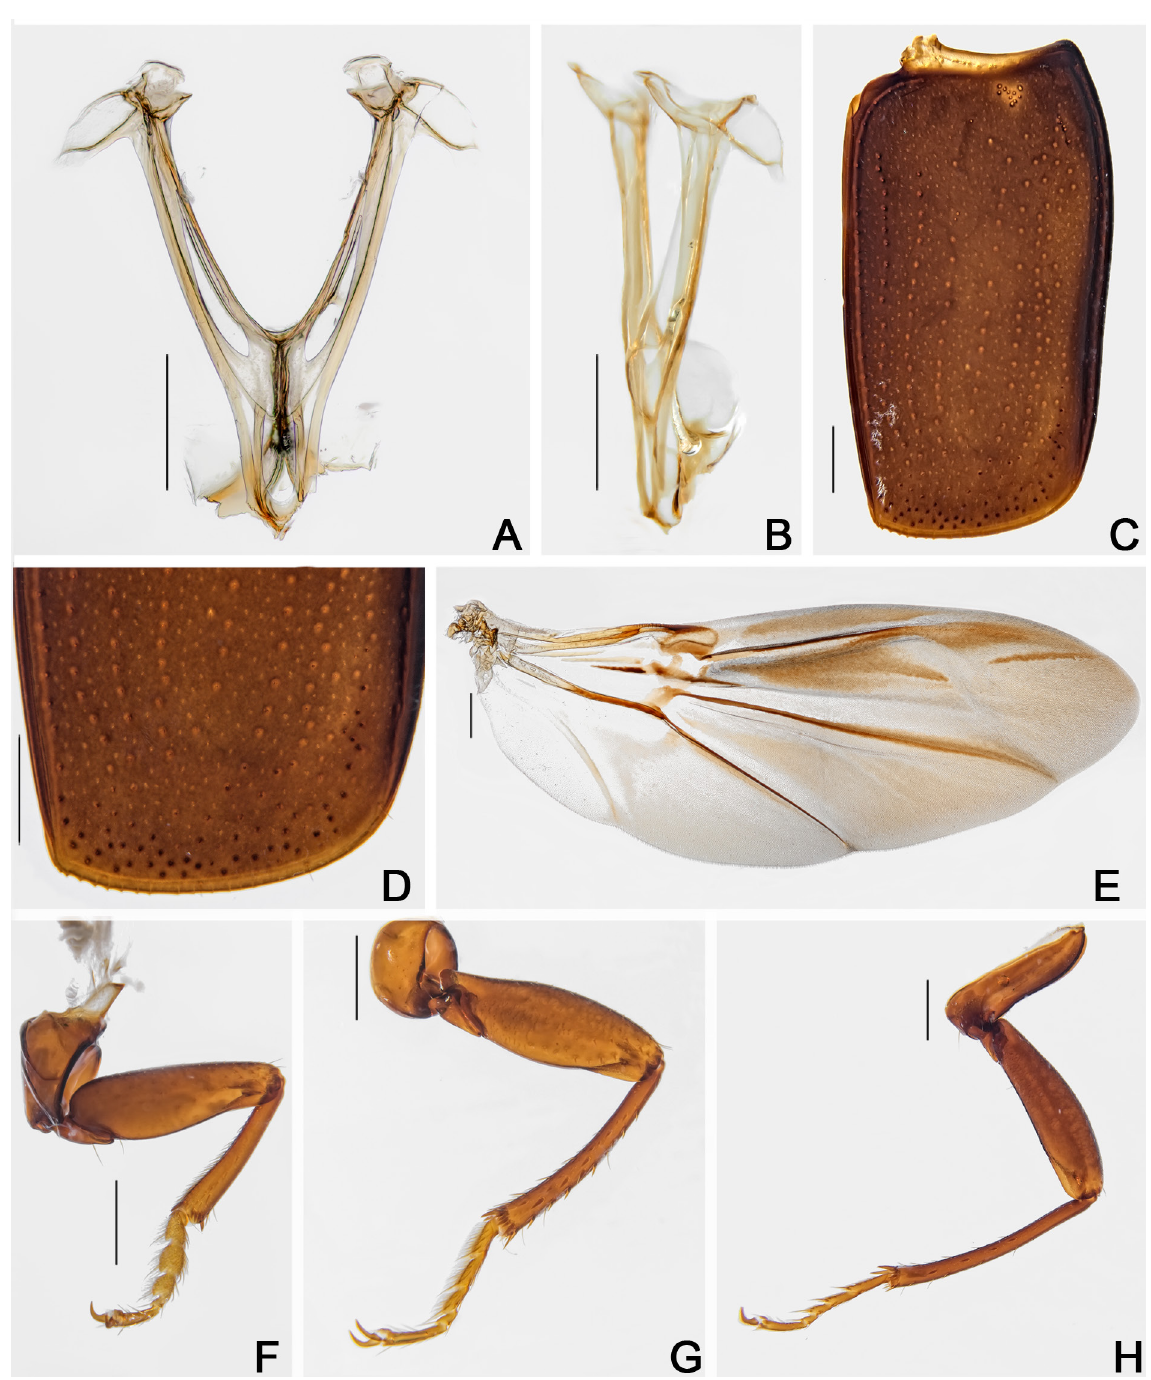
Fig. 60. Cyparium oberthueri Pic, 1956, ♂♂ (CELC). A–B . Metendosternite. A . Dorsal view. B . Lateral view. C–D . Elytron. C . Entire. D . Apex. E . Hind wing. F–H . Legs. F . Fore. G . Middle. H . Hind. Specimens collected at Mata da Biologia, Viçosa (MG, Brazil). Scale bars = 0.5